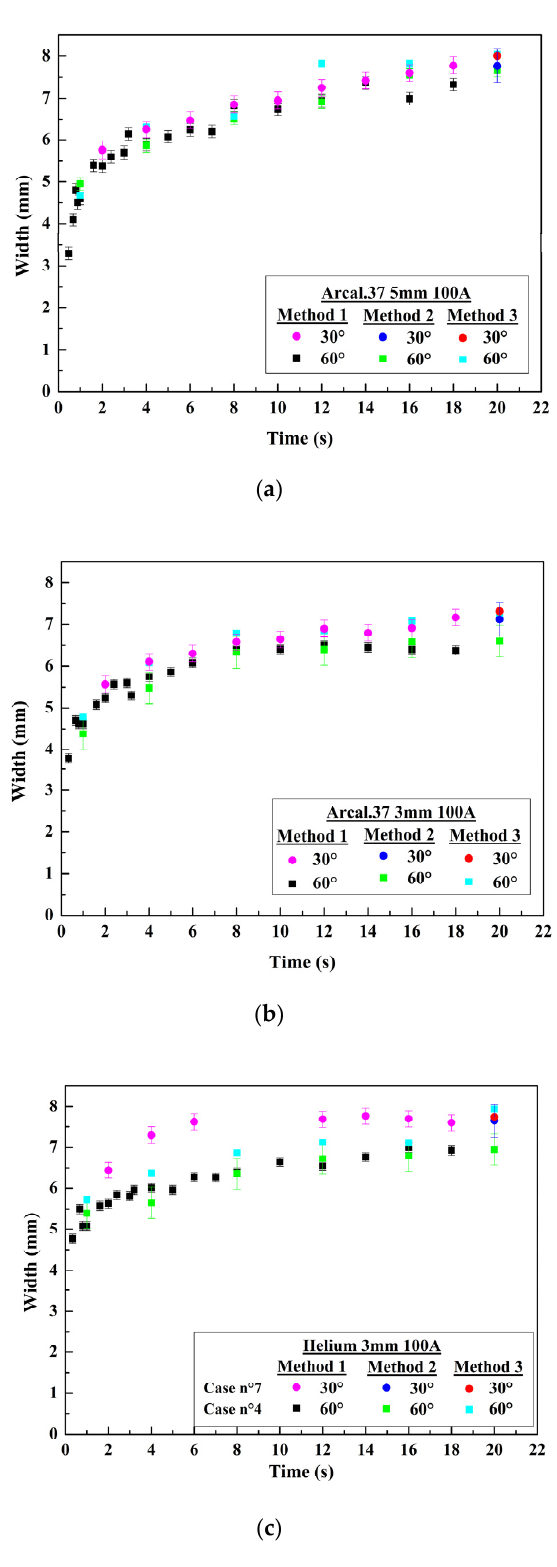
Figure 6. ( a ) Effect of the tip angle on the evolution of the weld pool width Arcal.37, 100 A, 5 mm; ( b ) Effect of the tip angle on the evolution of the weld pool width Arcal.37, 100 A, 3 mm; ( c ) Effect of the tip angle on the evolution of the weld pool width Helium, 100 A, 3 mm.